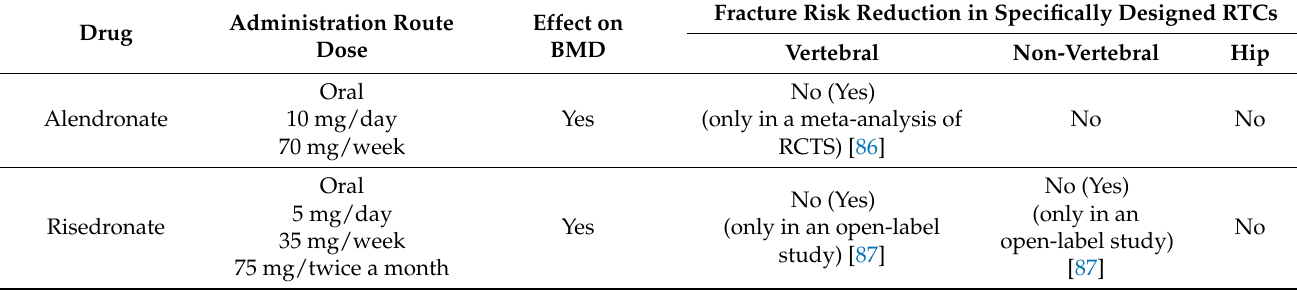
Table 2. Currently approved drugs for the treatment of osteoporosis in men. Administration Drug